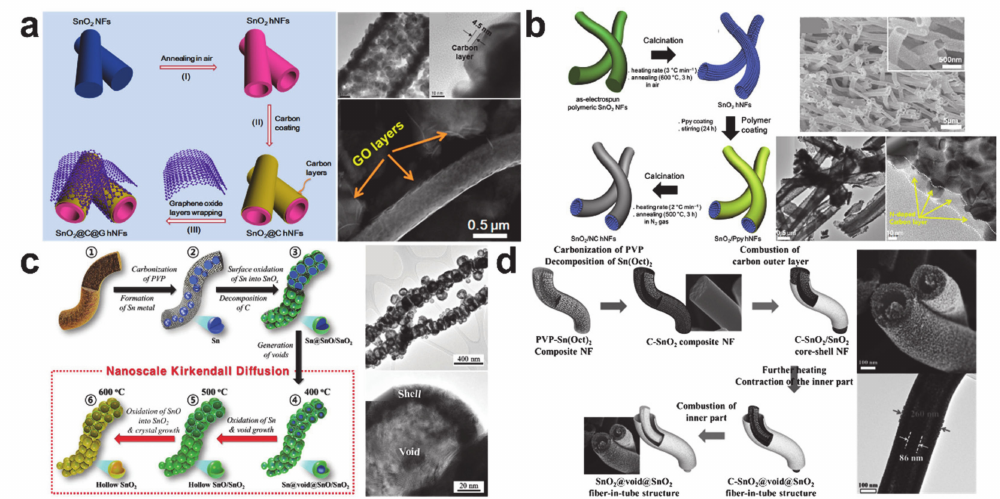
Figure 16. Hollow structured SnO 2 anode materials. ( a ) Carbon-coated and graphene oxide (GO) layer wrapped SnO 2 hollow nanofiber (reprinted with permission from [193]; copyright 2015 Elsevier), ( b ) nitrogen-doped carbon-coated SnO 2 hollow nanofiber (reprinted with permission from [194]; copyright 2017 Elsevier), ( c ) nanofiber composed with hollow SnO / SnO 2 nanospheres (reprinted with permission from [195]; copyright 2015 John Wiley and Sons), and ( d ) fiber-in-tube structured SnO 2 nanofiber (reprinted with permission from [196]; copyright 2014 John Wiley and